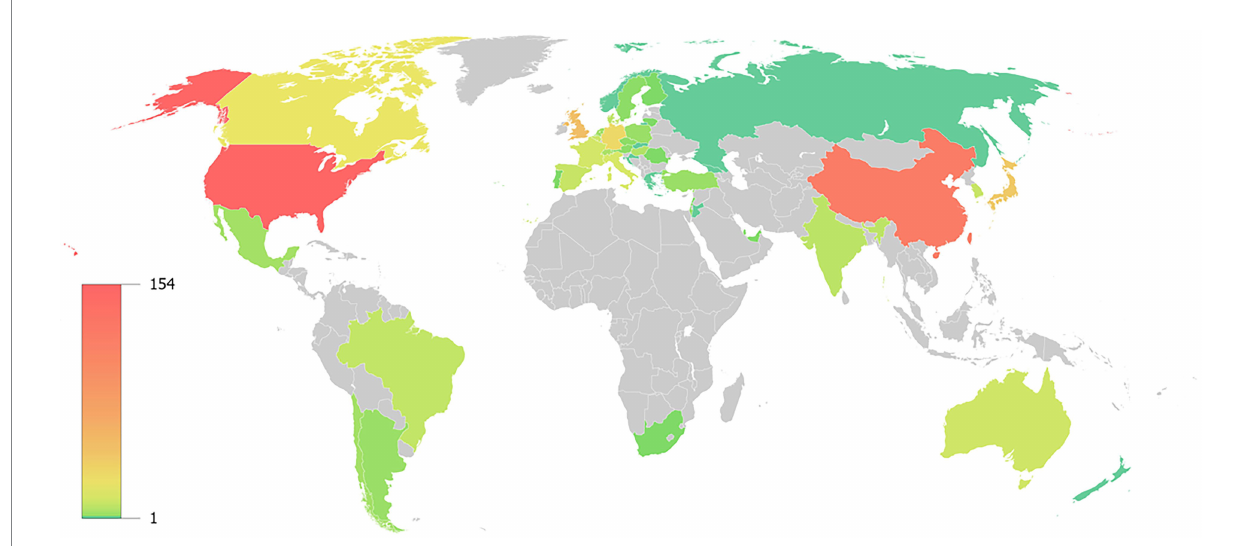
FIGURE 3 Geographical distribution of 50 countries is depicted, with the color bar on the left being linear.